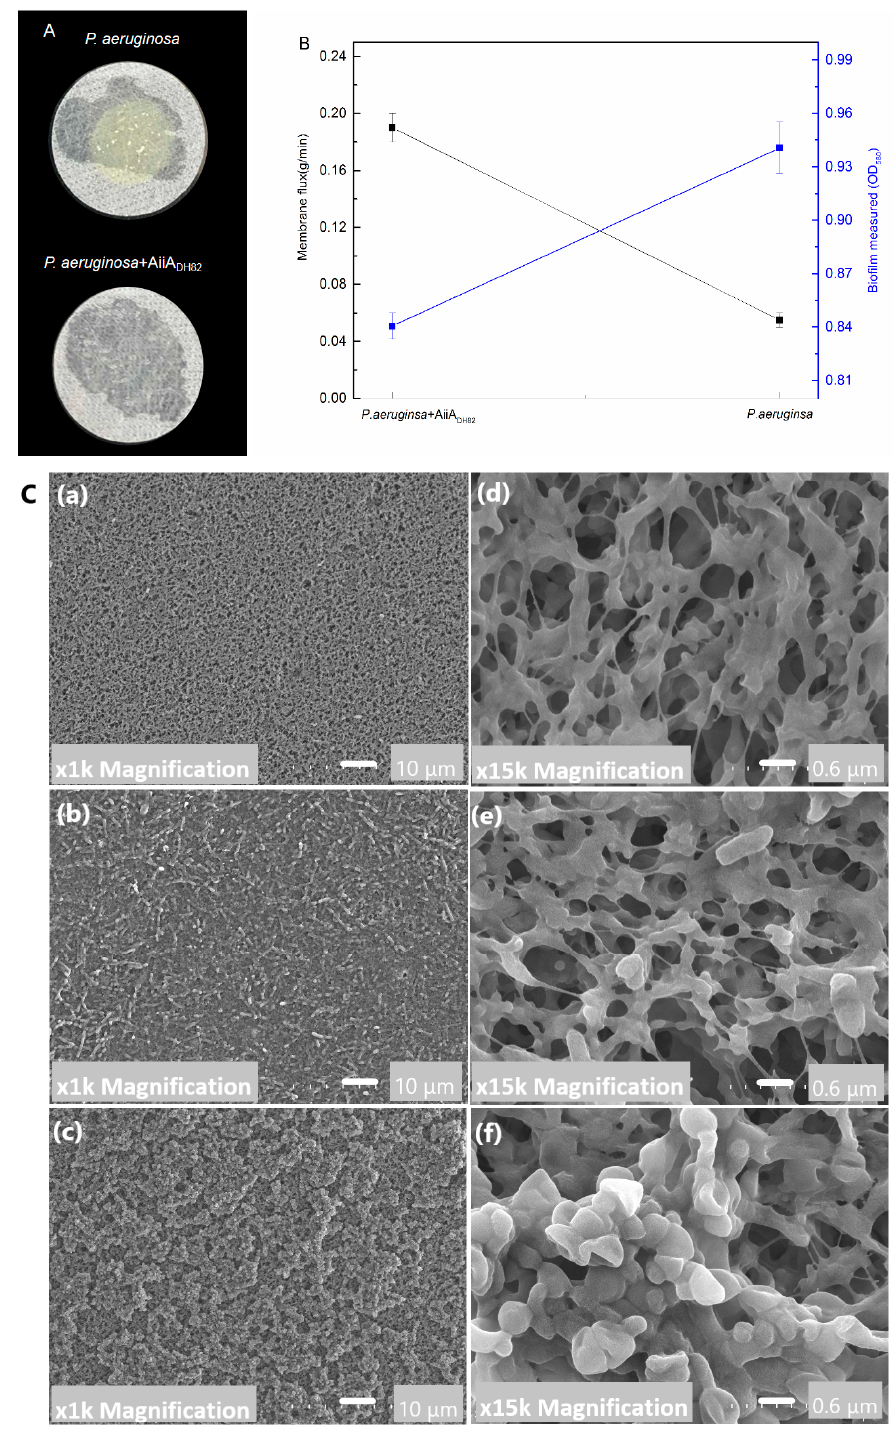
Figure 6. Antifouling capacity of the QQ enzyme against P. aeruginosa . Here, 1.5 mg / mL AiiA DH82 ismixed with the bacterial culture and is continuously pumped through a 0.22 µ m PVDF filter membrane for 3 d. Panel ( A ): Pictures of the filter membrane. Panel ( B ): Biofilm and permeability after treatment. The permeability was determined by the flux of sterile water that flowed through the PVDF treated filter membrane per minute (g / min). The biomass of the biofilm stained by crystal violet is determined by absorbance at 600 nm. The error bars present the standard deviation. Panel ( C ): SEM images of biomass accumulation on the PVDF membrane after 3 d of filtration. ( a , d ) New PVDF membrane at 100 × and 15,000 × magnification; ( b , e ) membrane treated with AiiA DH82 at 1000 × and 15,000 × magnification; ( c , f ) untreated membrane at 1000 × and 15,000 ×